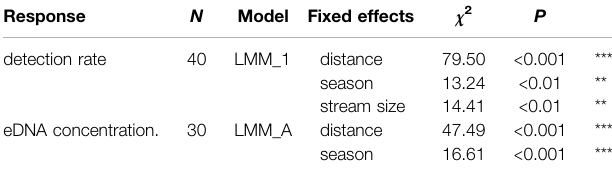
TABLE 5 | Fixed effects of spatio-temporal variables on the detection rate (proportion ofpositivePCRs)andeDNAconcentrationasassessedbymixed- model analysis with stream ID as a random factor ( see Table 4 for model statistics).